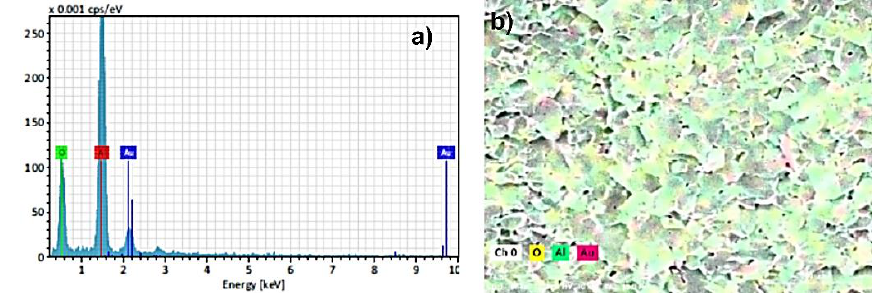
Figure 8. ( a ) EDS spectra and ( b ) SEM micrographs of surface fracture of Al 2 O 3 ceramics.